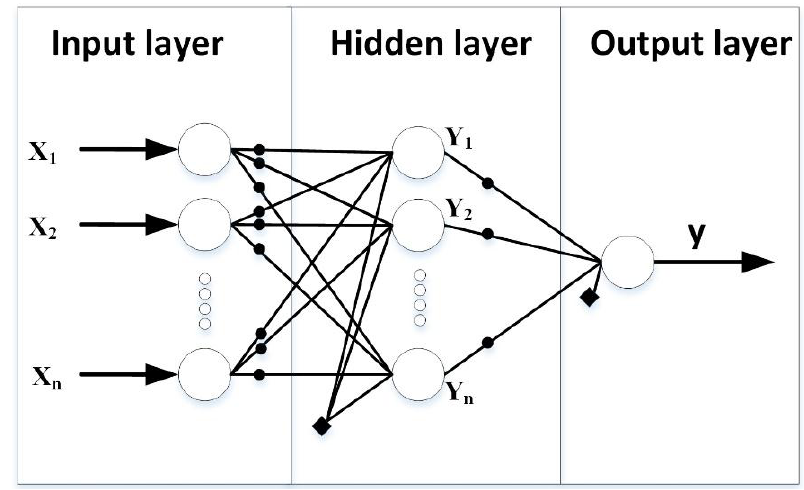
Figure 2. A typical feedforward neural network topology.